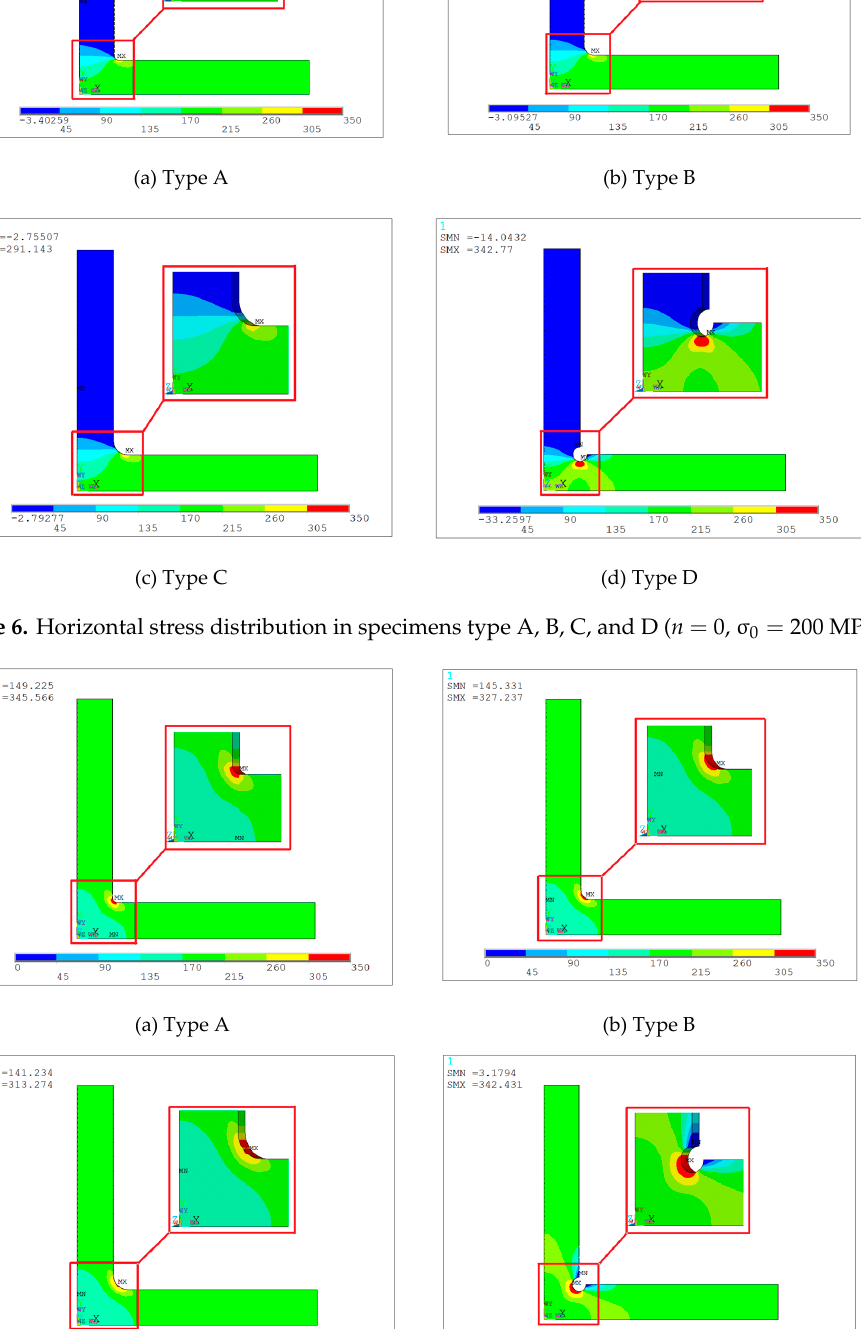
Table 1. σ (cid:3051)(cid:3051)(cid:2923)(cid:2911)(cid:2934) /σ (cid:3051)(cid:3051)(cid:2913)(cid:2915)(cid:2924)(cid:2930)(cid:2928)(cid:2915) for Type A, B, C, and D specimens ( n = 1, σ (cid:2868) = 200 MPa) Specimens